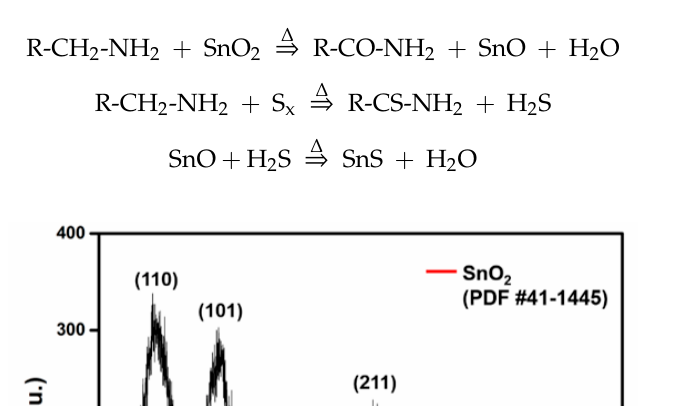
Figure 7. XRD pattern of the intermediate product before S-OAm reactant was added.